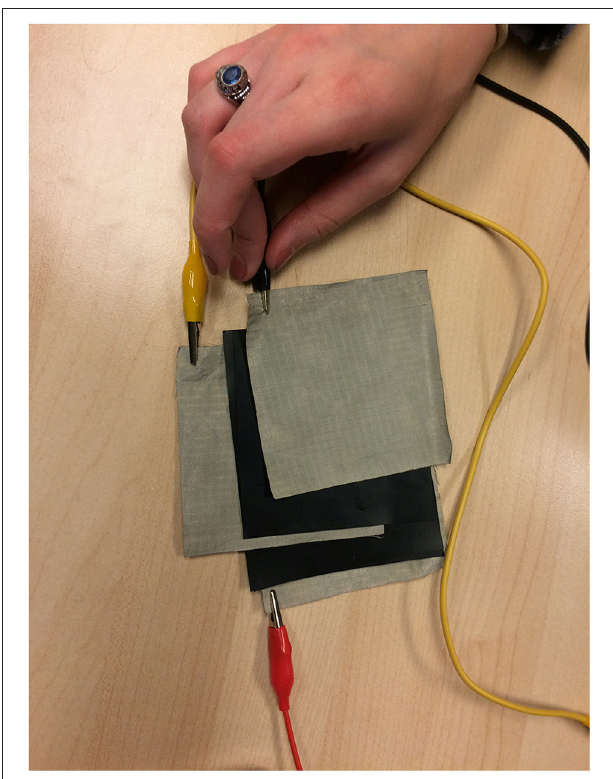
FIGURE 3 | Six alternating layers of conductive fabric and Velostat to build a XYZ pad.